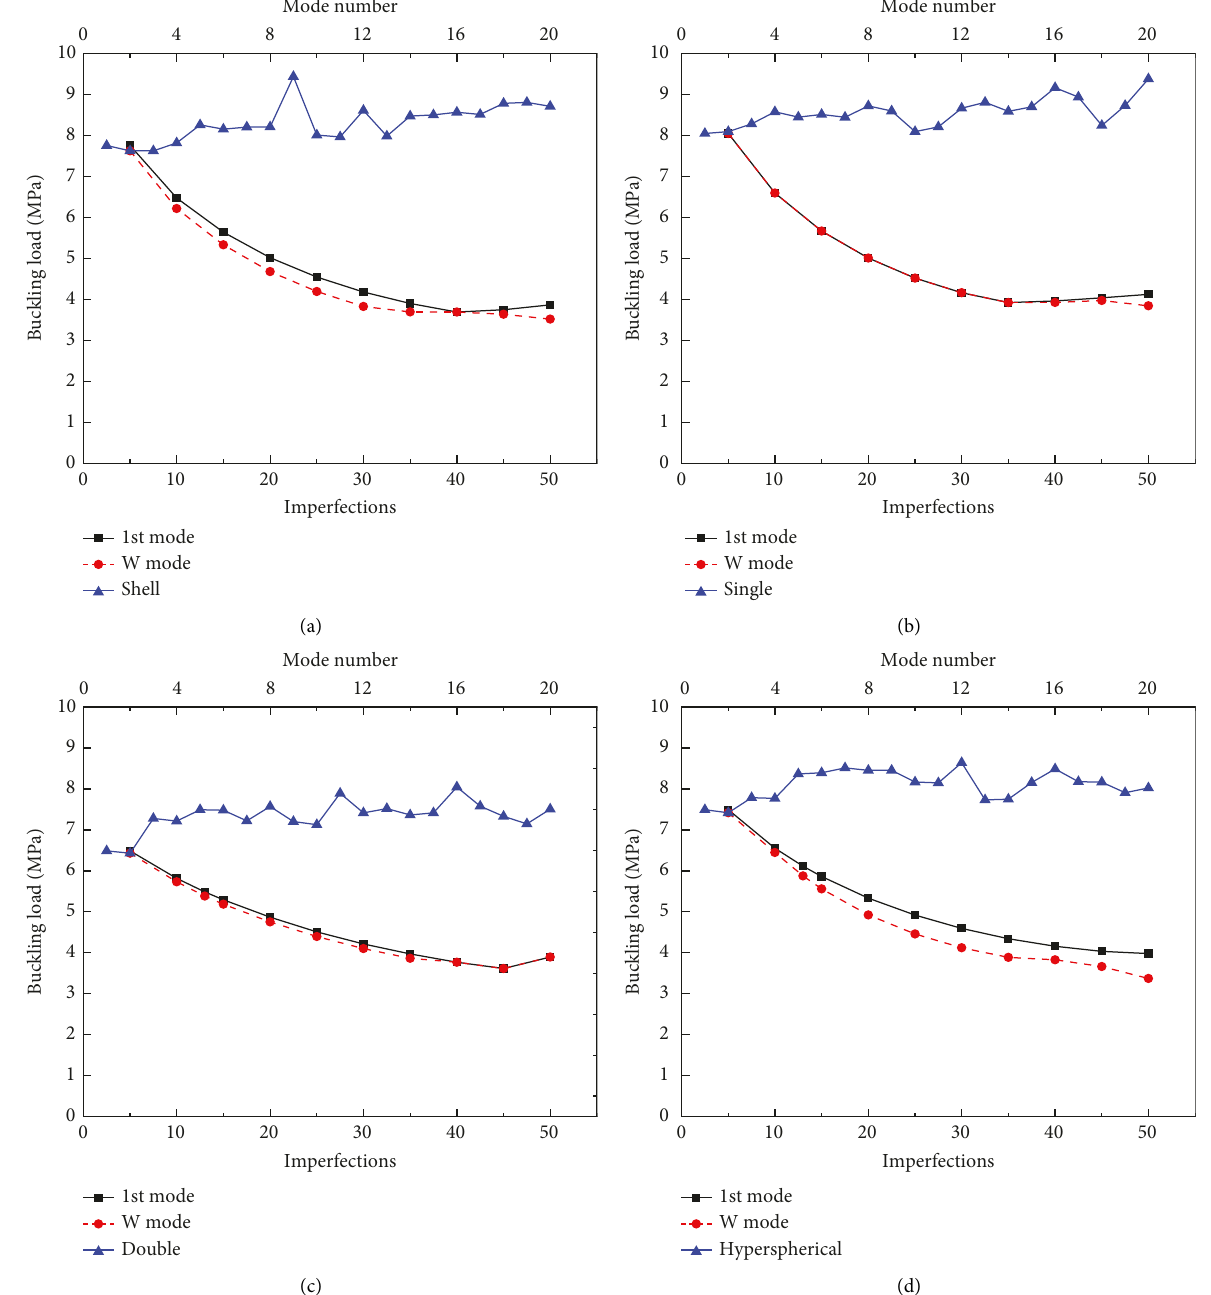
Figure 3: Comparison between first-order modal method and N-order modal method in buckling load of four types of spherical shells (a) Complete spherical shell (b) Spherical shell with single penetration (c) Spherical shell with double penetration (d) Hyperspherical